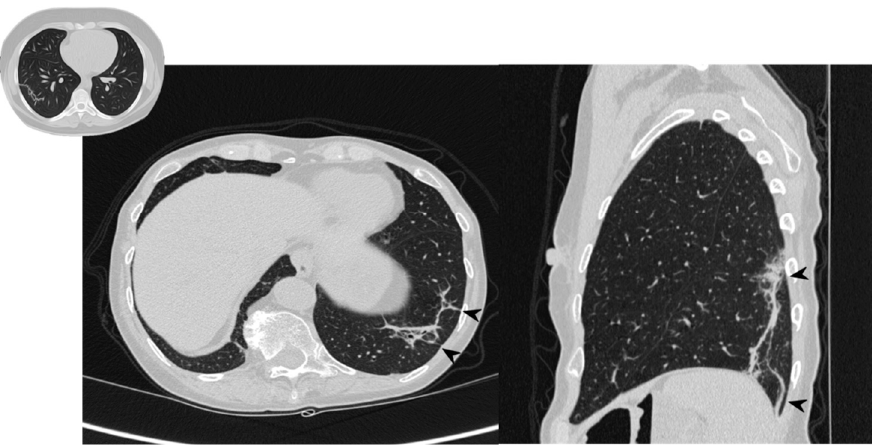
Figure 7. Linear and band-like opacities: sub-pleural curvilinear bands, parallel to the pleural (arrowheads) in a patient with COP.